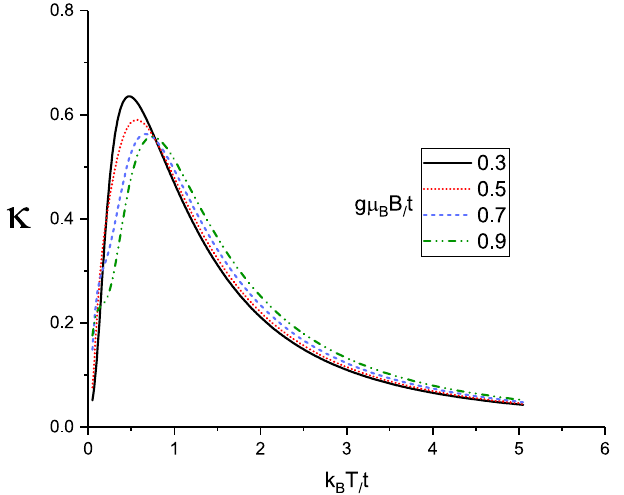
Figure 6. Thermal conductivity of Lieb lattice as a function of normalized temperature k B T / t for different values of normalized magnetic field g µ B B / t at fixed gap parameter �/ t = 0.3 . Normalized chemical potential and normalized spin-orbit coupling strength have been fixed at µ/ t = 1.0 and (cid:31) / t = 0.2 , respectively.